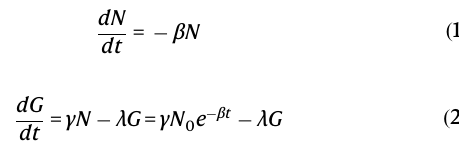
Fig. 4 | hIL-6 and hBAFF promote engraftment of ex vivo differentiated PCs. a Schematic describing in vivo infusion of ex vivo differentiated B cells. Mock ( n =4 animals) or hBAFF ( n =5 animals) edited cells were transferred into NSG mice engineered to express hIL-6 (hIL-6-NSG). It was partially created with BioRender.com. b – d ELISA was used to quantify B cell production of hIgG and hBAFF in NSG or NSG-hIL-6 animals. The line indicates the mean at each time point, and the shadow shows the 95% con fi dence intervals. Source data are provided as a Source Data fi le. e , f Using antibody secretion rate and antibody degradation rate as parameters (Supplementary Table 2), we fi tted curves to